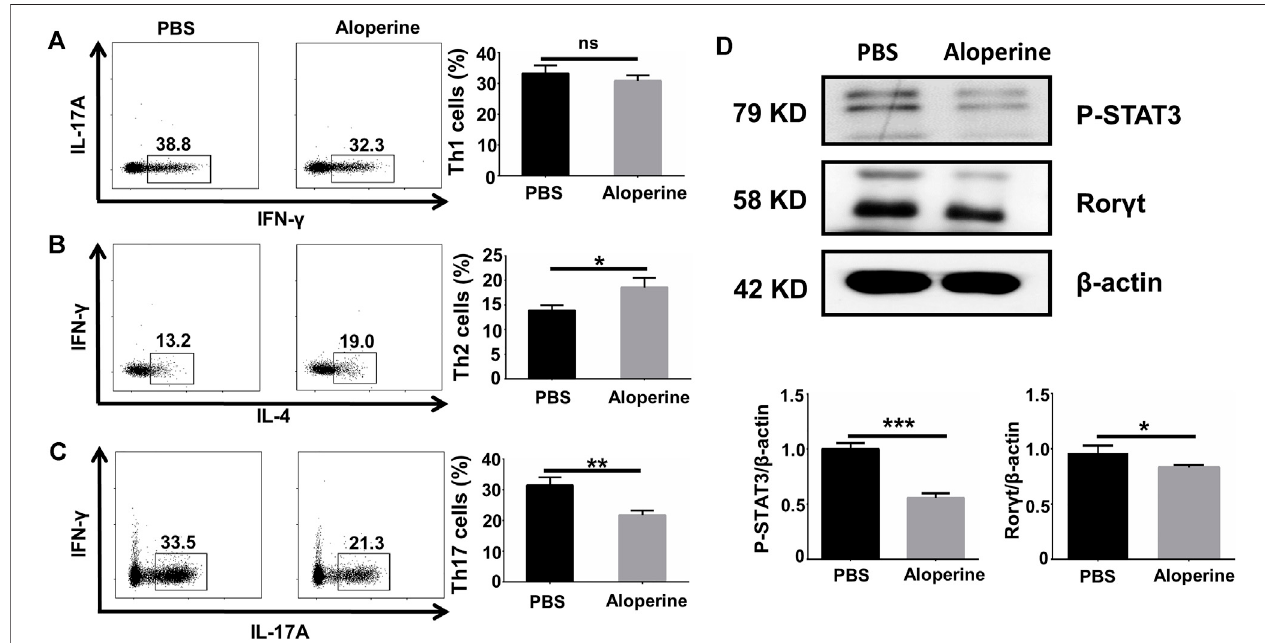
FIGURE 5 | Aloperine directly affects Th17 in vitro differentiation by inhibiting the STAT3 signalling. (A – C) IFN- γ + Th1, IL-4 + Th2, and IL-17A + Th17 polarizing ef fi ciency were analyzed by fl ow cytometry. (D) The levels of ROR γ t and phosphorylated STAT3 were assessed by western blotting. The results were from three independent experiments. The values are presented as the mean ± SEM. p p < 0 05; pp p < 0.01; ppp p < 0.001; and ns, p ≥ 0.05.